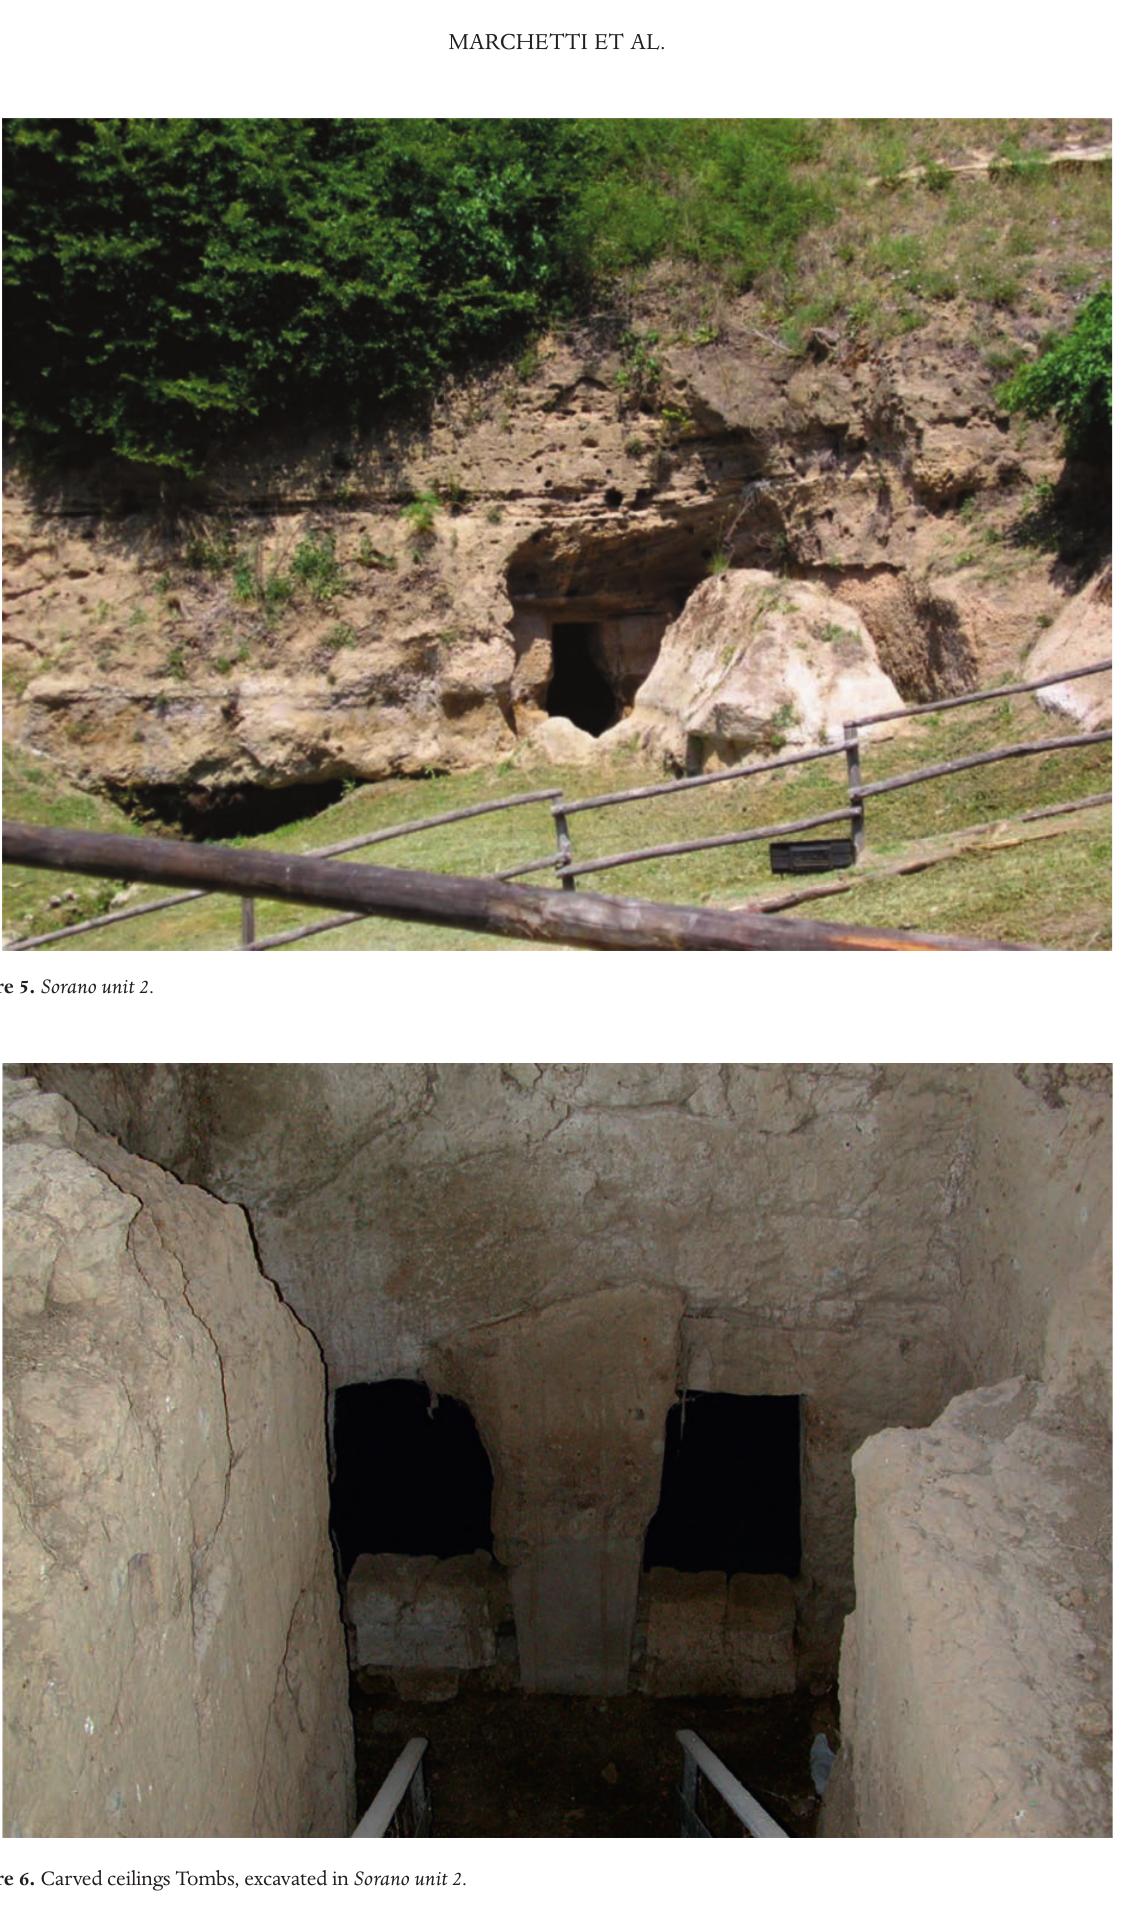
Figure 6. Carved ceilings Tombs, excavated in Sorano unit 2